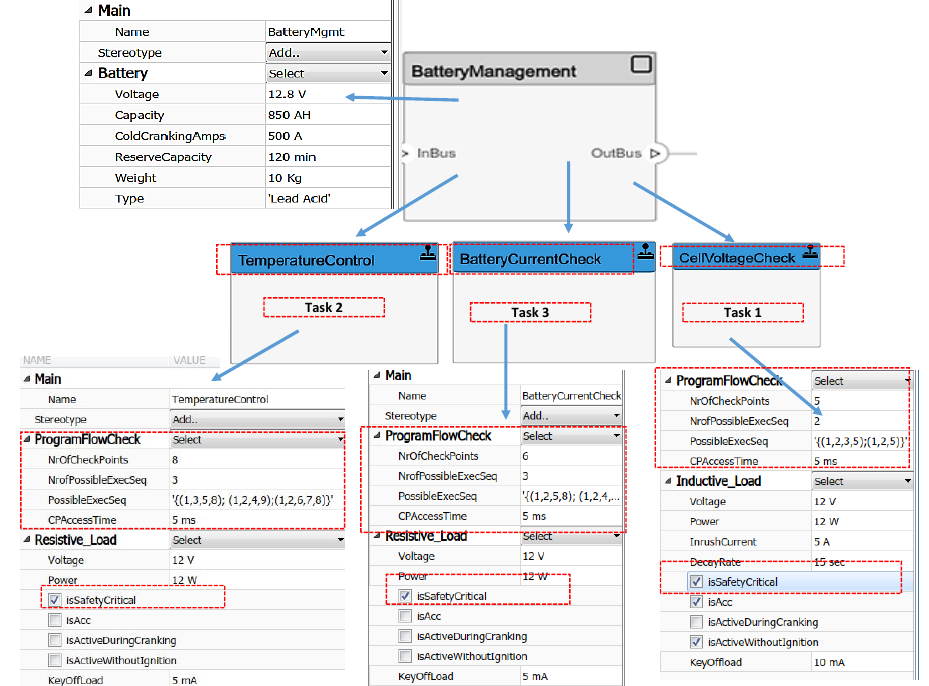
Figure 6. Model-based configuration of program flow check parameters with ProgramFlowCheck profile.